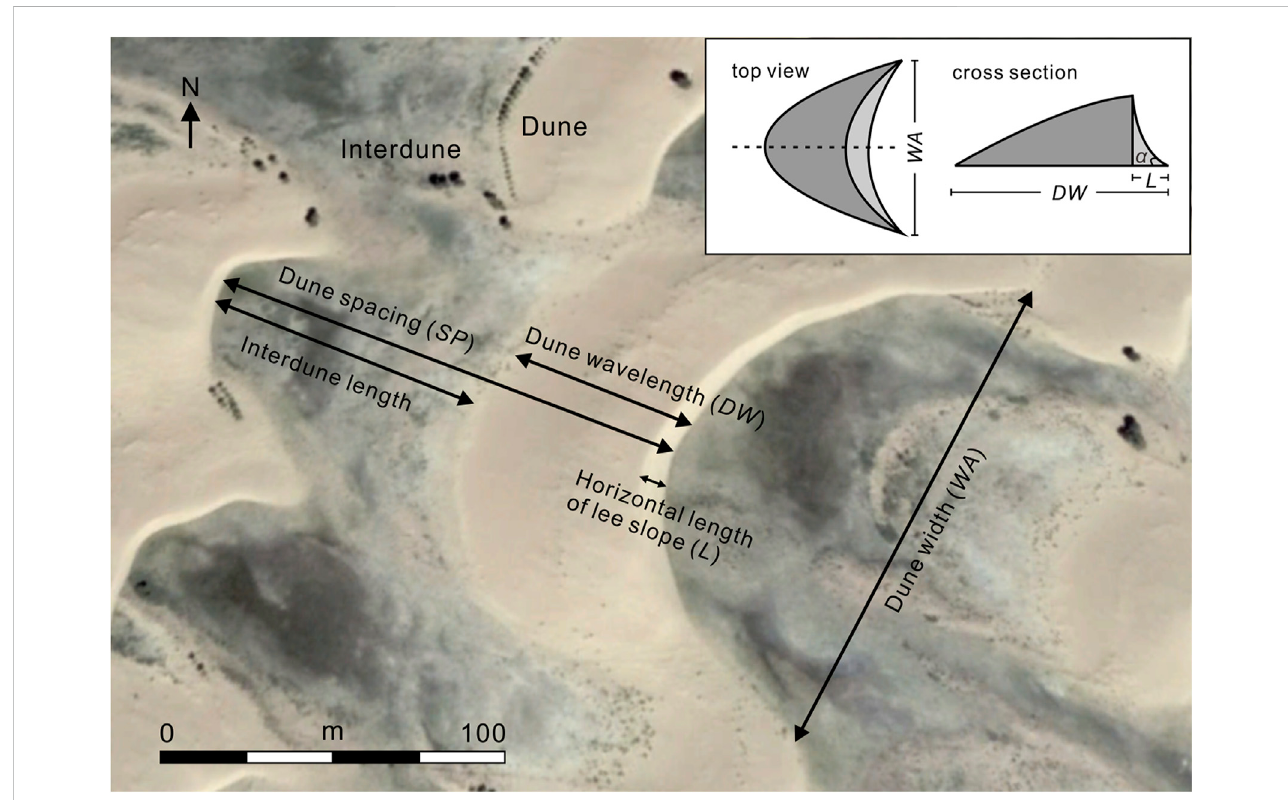
FIGURE 4 Remote-sensing image of dune and interdune of the Hobq Desert, including de fi nitions of the terminology used in this study to quantitatively describe their morphology and geometry. Sketch map in top view and cross section of a dune is at the top right. H -original dune height; L -horizontal length of dune slipface; α -angle of